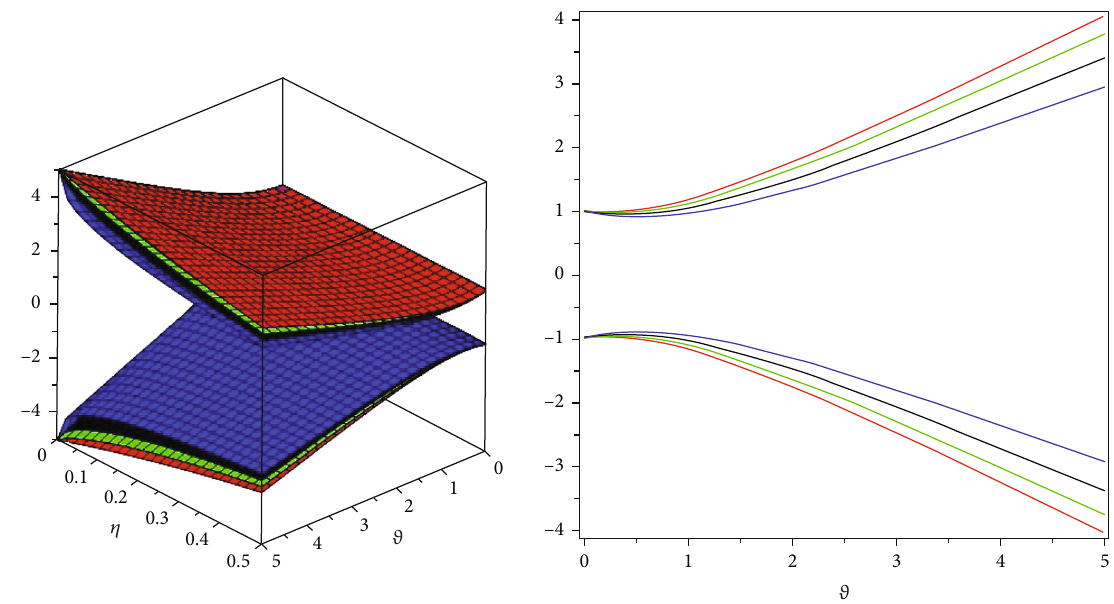
Figure 2: The various fractional order ϱ fi gures of upper and lower branches of analytical